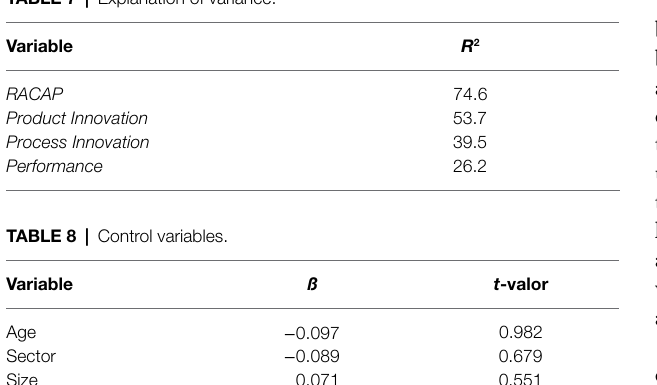
TABLE 7 | Explanation of variance.